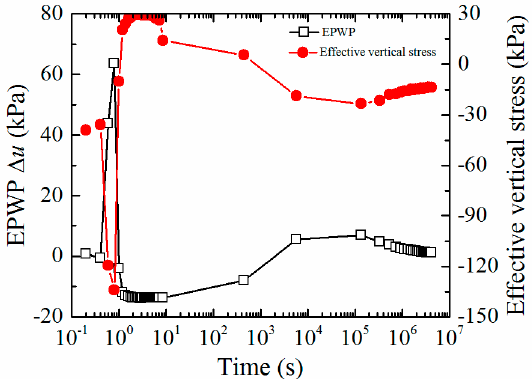
Figure 19. Time histories of the EPWP and effective stress of soil at depth of 1.4 m at z p = 7.8 m.